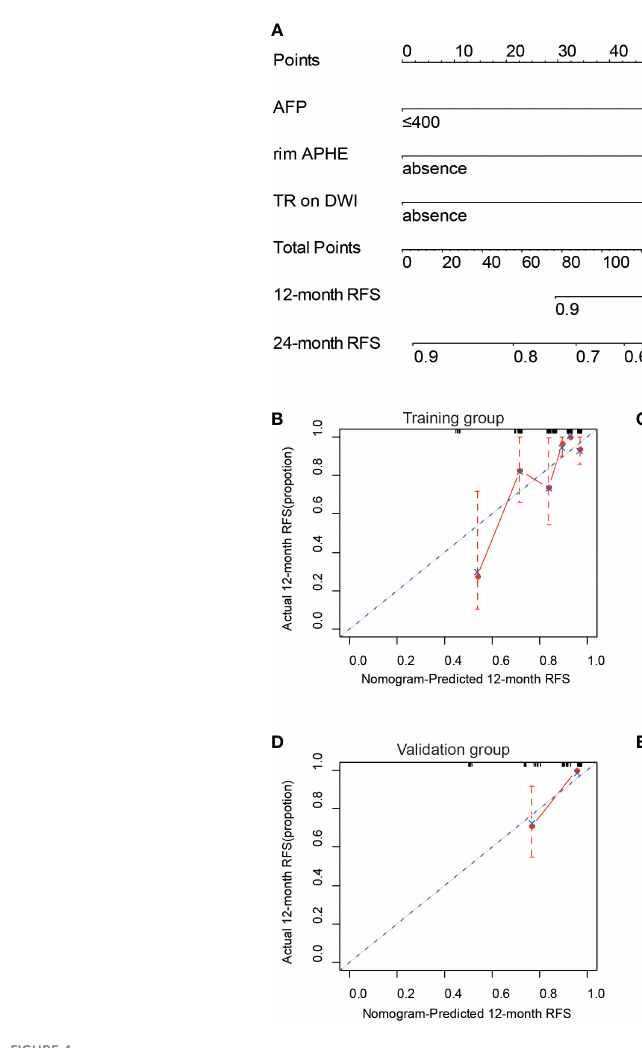
FIGURE 4 Construction and validation of nomogram for predicting RFS of patients with sHCC with RFA as the fi rst-line therapy. (A) Integrated nomogram for predicting probability of 12- and 24-month after RFA of sHCC. The calibration curves for the nomogram-predicted 12-month RFS (B) and the nomogram-predicted 24-month RFS (C) in the training cohort and the nomogram-predicted 12-month RFS (D) and the nomogram-predicted 24-month RFS (E) in the validation cohort.